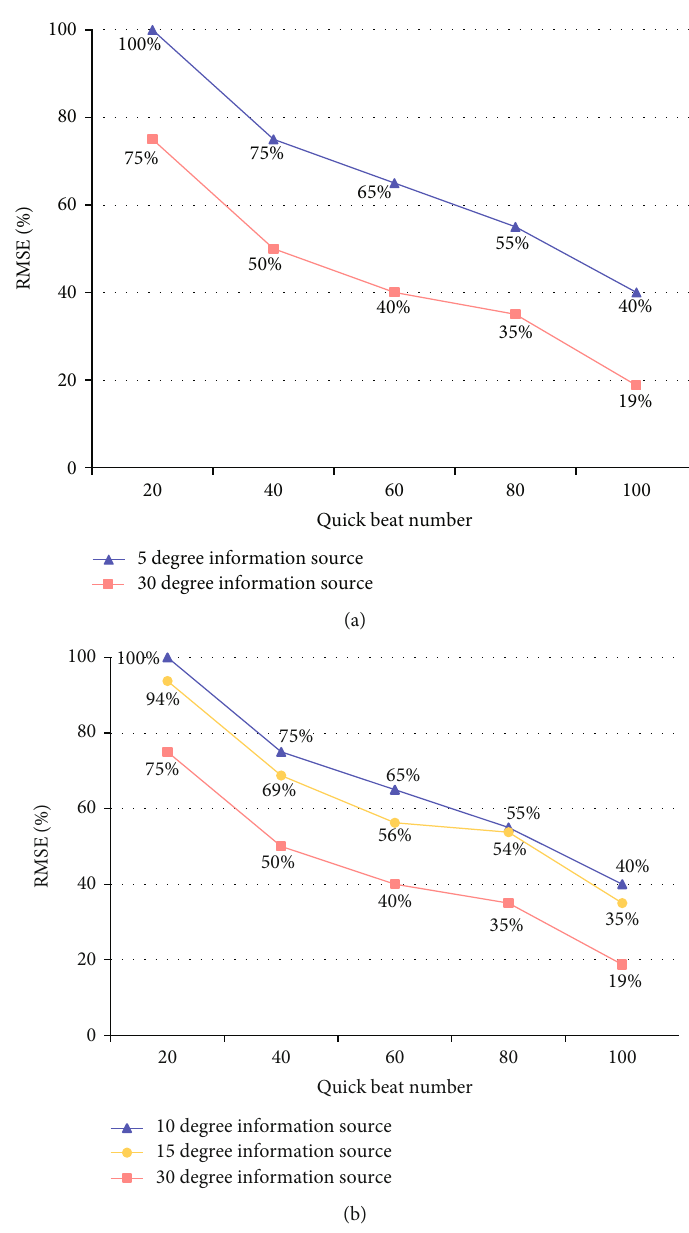
Figure 7: RMSE results of multiple sources with the number of snapshots for the T-matrix reconstruction